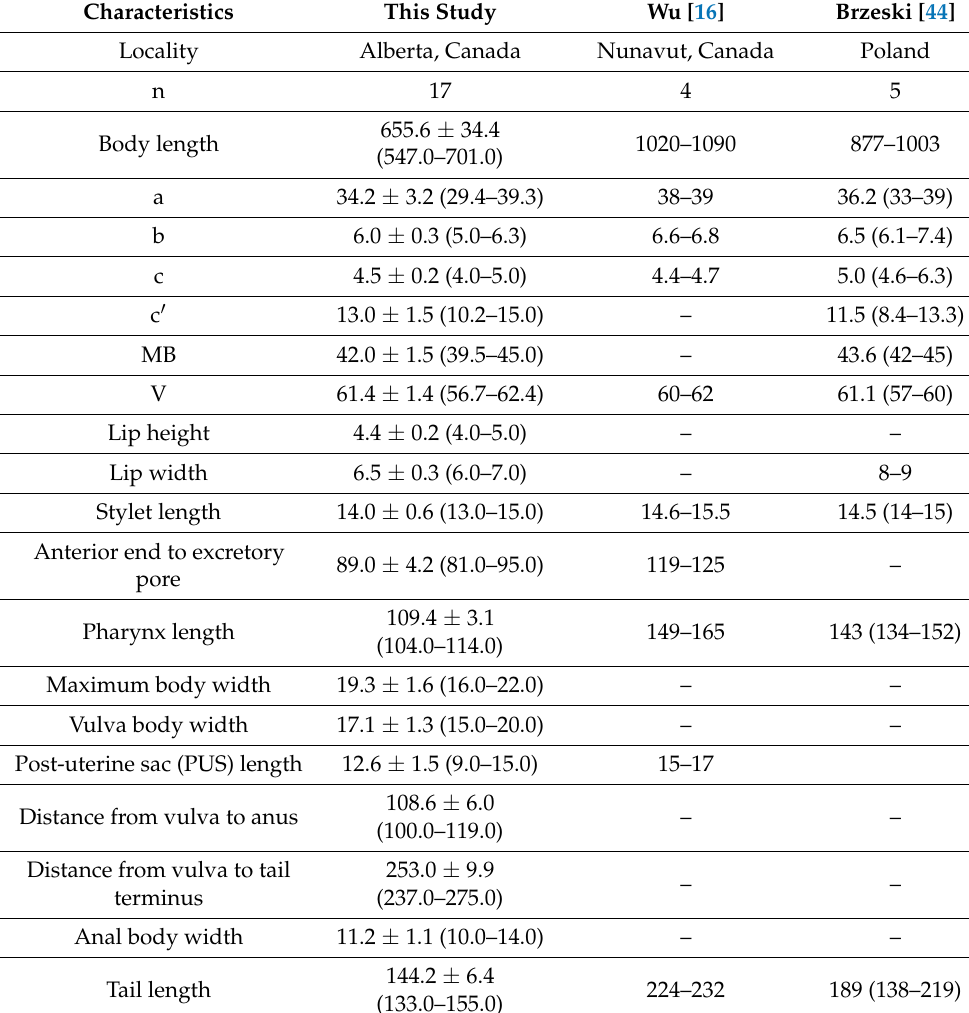
Table 2. Morphometrics of female Filenchus hazenensis (Wu) Andr á ssy [16,20] examined in this study and from the original and subsequently published descriptions. All measurements are in µ m and in the form: mean ± standard deviation and/or